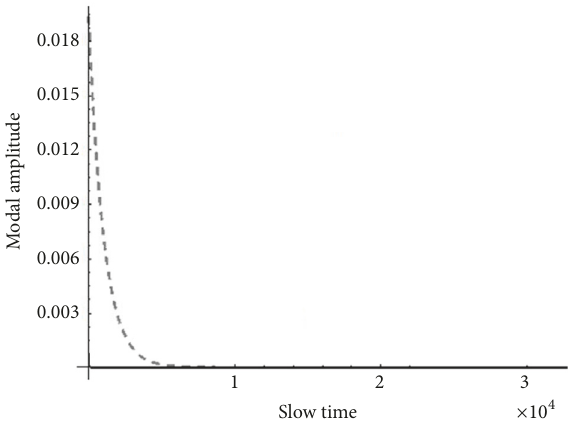
Figure 4: Undamped modal amplitudes.